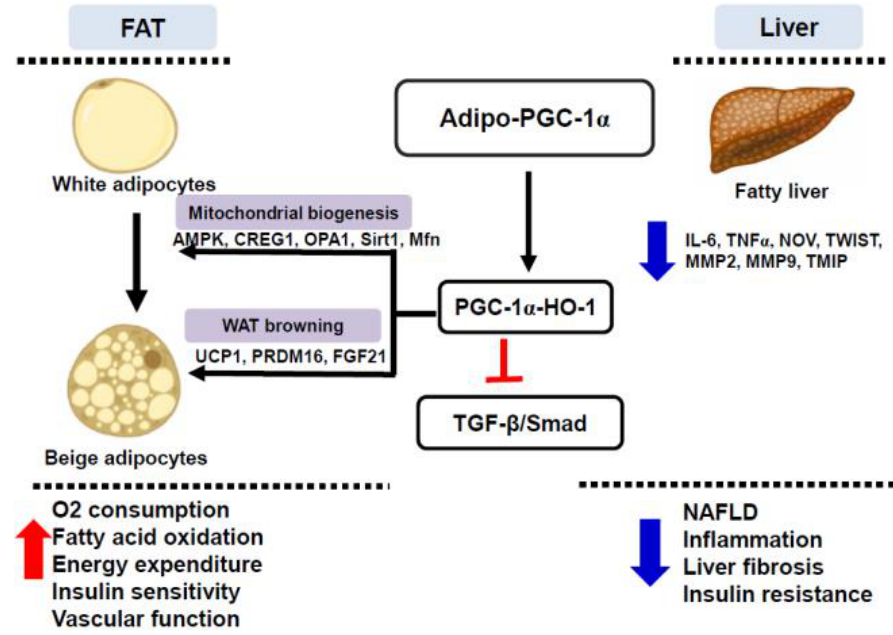
Figure 10. Schematic depiction of the postulated hypothesis showing that adipocyte-specific PGC-1 α expression coordinates HO-1 to induce the conversion of white adipocytes to the beige pheno- type, and improves mitochondrial biogenesis/fusion, energy expenditure, and insulin sensitivity as well as vascular function. Adipo-PGC-1 α inhibits TGF- β /Smad signaling (pSmad 1–5, Smad 2 and P38MAPK) and inflammatory adipokines (NOV/CCN3 and IL-6). Selective expression of adipocyte PGC-1 α provides a genetic approach for obesity, fatty liver, and associated metabolic syndrome management.